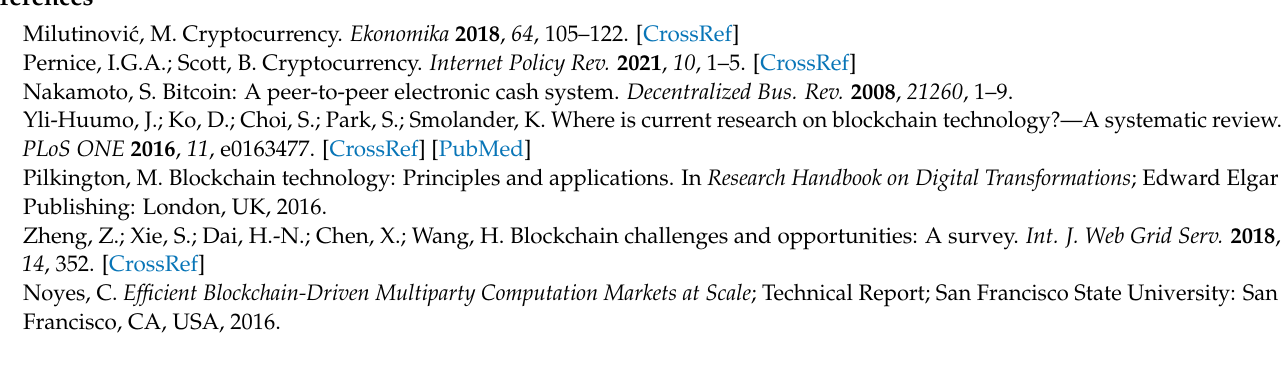
Figure S2: Volatility confidence interval for Ethereum. Figure S3: VaR confidence interval for Litecoin. Figure S4: Volatility confidence interval for Litecoin. Figure S5: VaR confidence interval for Ripple. Figure S6: Volatility confidence interval for Ripple. Figure S7: VaR confidence interval for Bitcoin Cash. Figure S8: Volatility confidence interval for Bitcoin